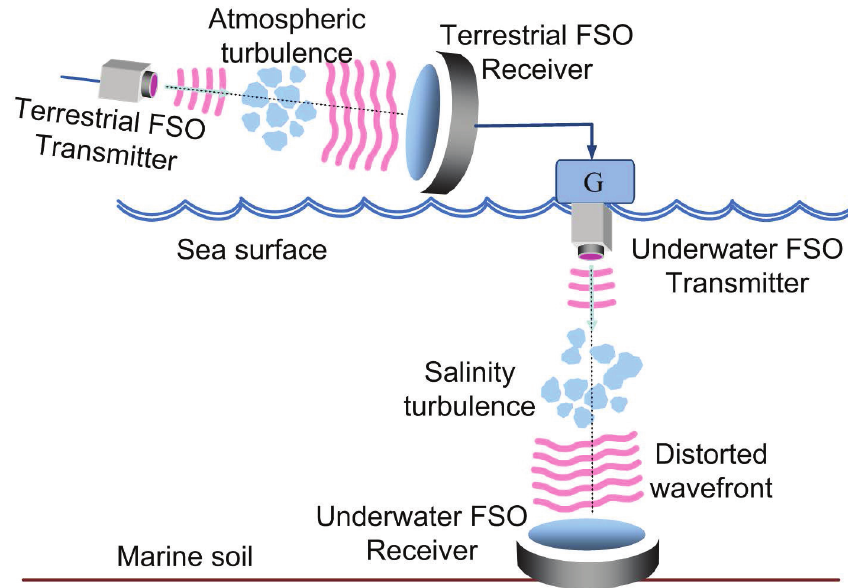
Figure 1. AF-based TU-FSO system model, based on the one in